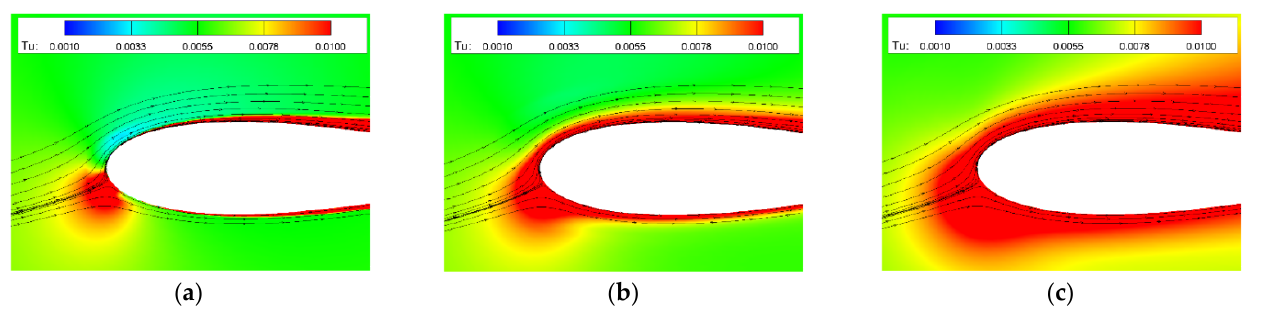
Figure 8. Computed turbulence intensity distribution and streamlines predicted by γ -Re θ t SST-2003 at α = 8°. ( a ) R T,FS = 0.1. ( b ) R T,FS = 1.0. ( c ) R T,FS = 10.